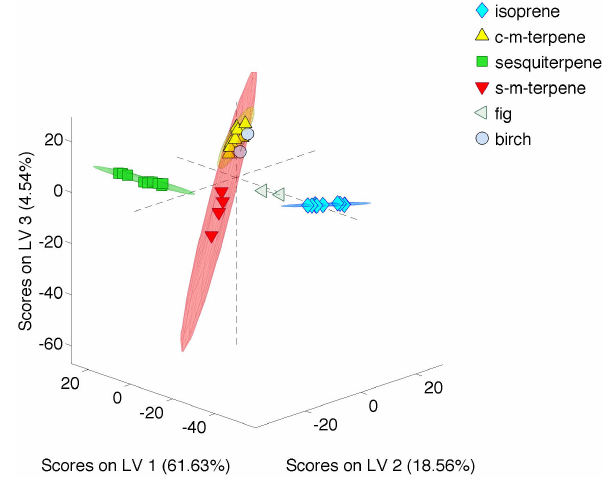
Figure 6. Scores plot of the first three latent variables derived from the PLS-DA model analysis of the isoprene, cyclic monoterpene ( α -pinene and limonene), sesquiterpene ( β -caryophyllene), straight chain monoterpene (myrcene and linalool), fig and birch chamber data. Classification confidence level is